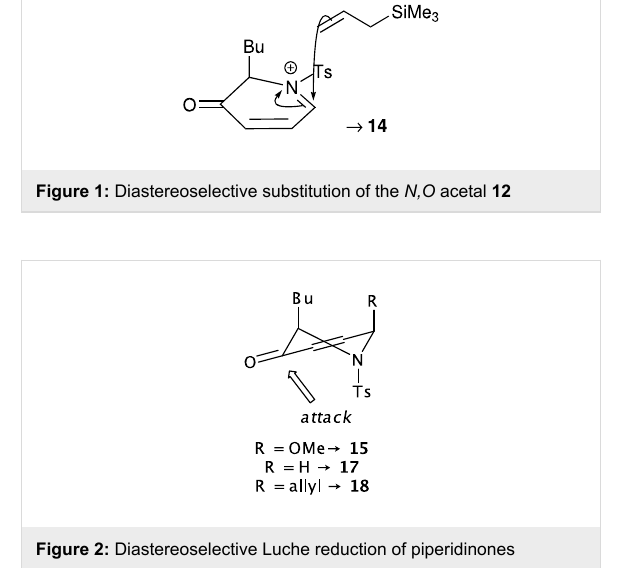
20A , 21A and 22A ): dihydroxylation occurred anti to the hydroxyl group, and none of the syn product could be detected in the 500 MHz 1 H NMR spectra of the crude reaction mixtures (see Figure 3, and entries 1a, 3a and 5, Table 1). In the case of 18 , the dihydroxylation of the allyl group was not diastereose- lective, and a 50:50 mixture of epimers was obtained. The stereoelectronic preference for dihydroxylation anti to an allylic hydroxyl group has been recognised previously.[45]